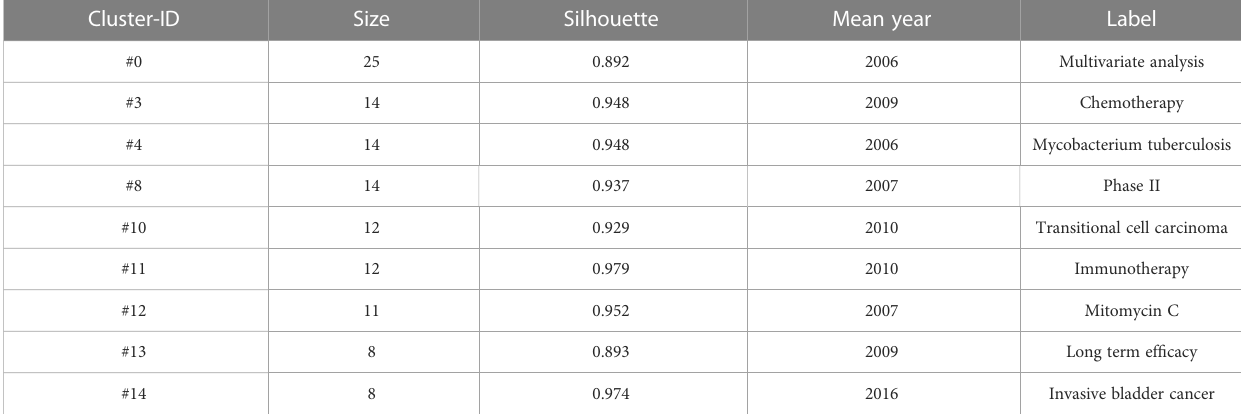
TABLE 4 The top 10 largest clusters of co-cited references in BCG treatment of